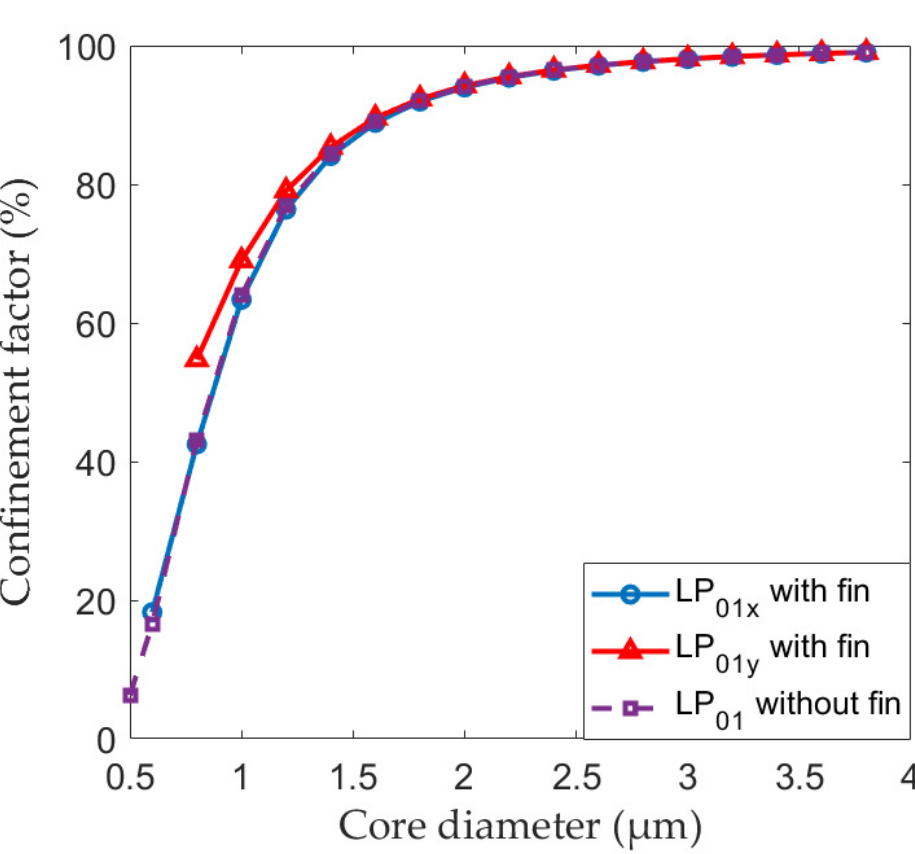
Figure 6. Variation of the confinement factor inside the core with and without a fin of 1.5 µm height.